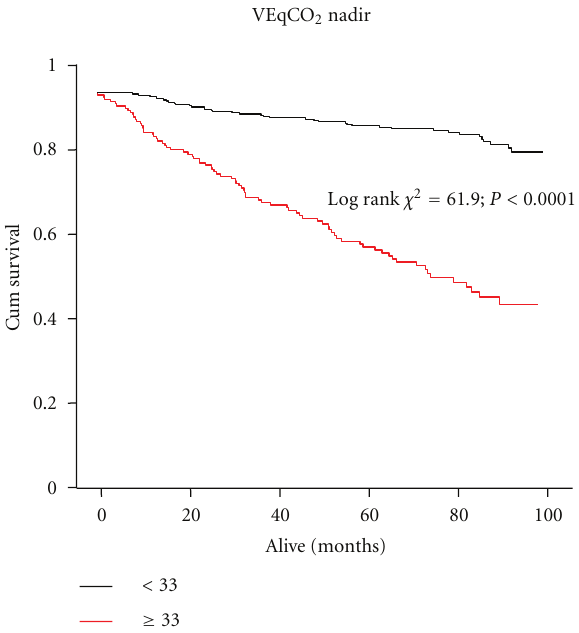
Figure 6: Kaplan-Meier survival curve showing peak VO 2 -data dichotomised by optimal cut-points ( < 20mL · kg − 1 · min − 1 n = 184 patients, event free survival 60%; ≥ 20 mL · kg − 1 · min − 1 n = 239 patients, event free survival